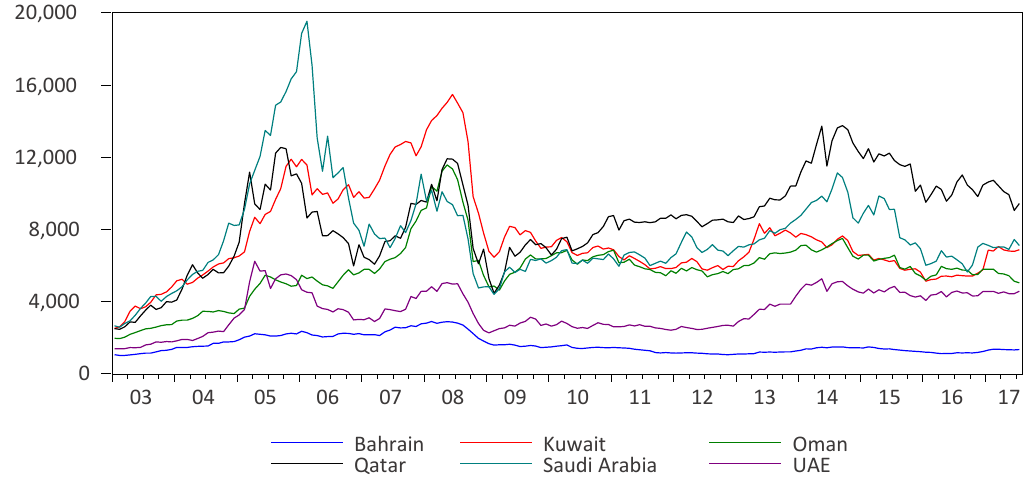
Figure 2. Monthly trend of all 6 stock markets of GCC from 1/1/2003 to